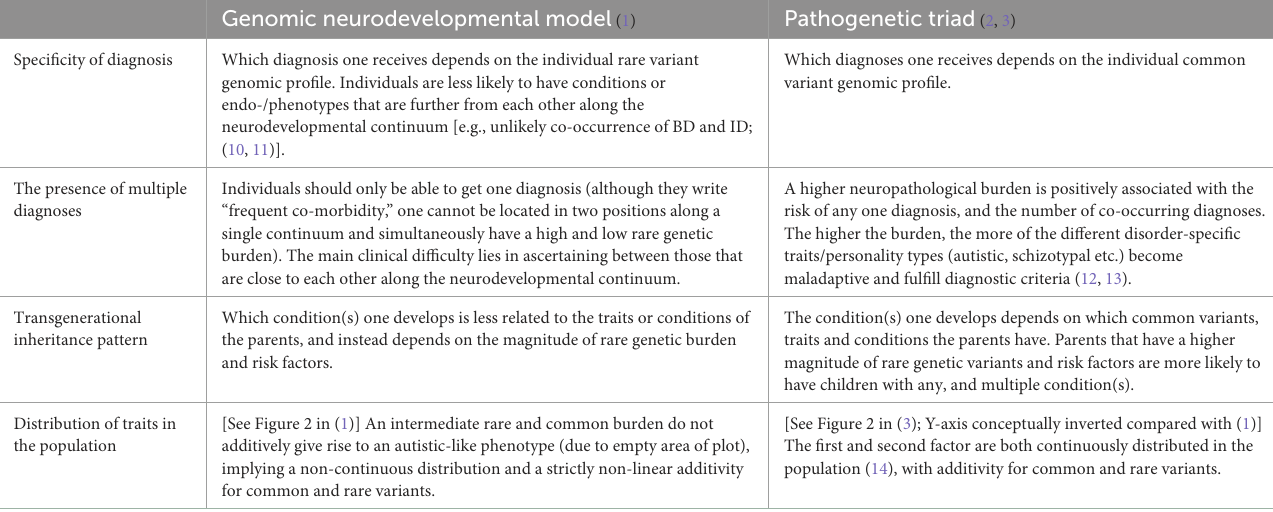
TABLE 1 Testable postulates for differences between the operationalizations. Genomic neurodevelopmental model (1) Pathogenetic triad (2,